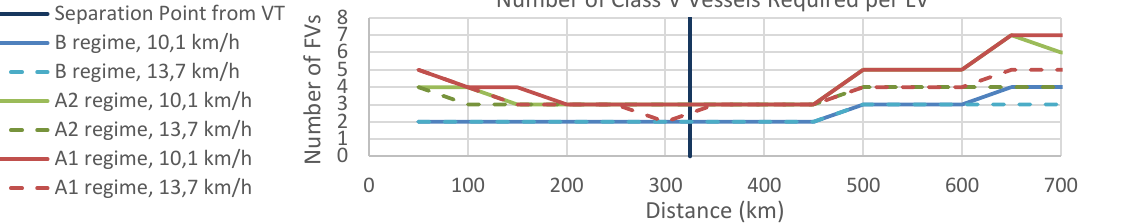
Number of Class IV Vessels Required per LV